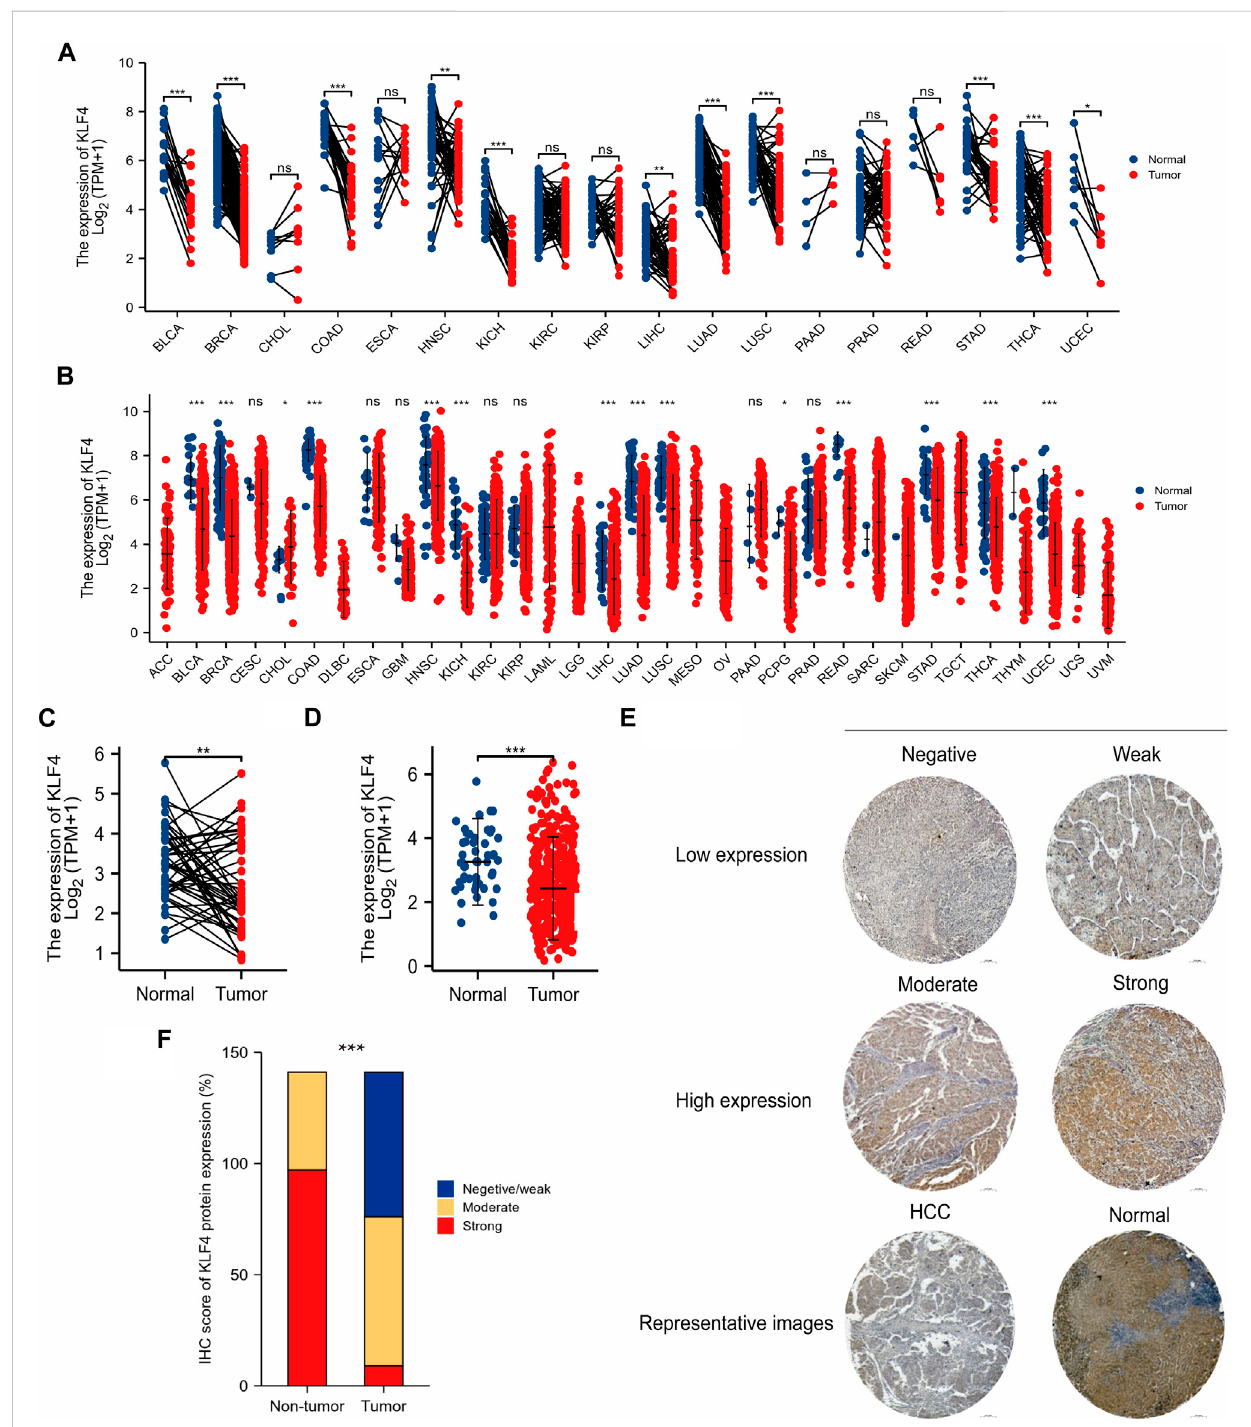
FIGURE 1 Low expression of KLF4 in HCC (A,B) KLF4 expression in various cancer in tumor samples with paired and unpaired normal tissues respectively (TCGA) (C,D) KLF4 expression in HCC tumor samples with paired and unpaired normal tissues respectively (TCGA) (E) The characteristic images of four- level IHC scores and the representative image of IHC in TMA (F) KLF4 expression level in HCC tumor tissues and adjacent tissues of TMA. ACC, adrenocorticalcarcinoma;BLCA,bladderurothelialcarcinoma;BRCA,breastinvasivecarcinoma;CESC,cervicalendocervicaladenocarcinomaand squamouscellcarcinoma;CHOL,cholangiocarcinoma;COAD,colonadenocarcinoma;DLBC,lymphoidneoplasmdiffuselargeb-celllymphoma;ESCA, esophagealcarcinoma;GBM,glioblastomamultiforme;HNSC,headandnecksquamouscellcarcinoma;KICH,kidneychromophobe;KIRC,kidneyrenal clearcellcarcinoma;KIRP,kidneyrenalpapillarycellcarcinoma;LAML,acutemyeloidleukemia;LGG,brainlowergradeglioma;LIHC,liverhepatocellular carcinoma; LUAD, lung adenocarcinoma; LUSC, lung squamous cell carcinoma; MESO, mesothelioma; OV, ovarian serous cystadenocarcinoma; PAAD, pancreatic adenocarcinoma; PCPG, pheochromocytoma and paraganglioma; PRAD, prostate adenocarcinoma; READ, rectum adenocarcinoma; SARC, sarcoma; SKCM, skin cutaneous melanoma; STAD, stomach adenocarcinoma; TGCT, testicular germ cell tumors, THCA, thyroid carcinoma; THYM, thymoma; UCEC, uterine corpus endometrial carcinoma; UCS, uterine carcinosarcoma; UVM, uveal